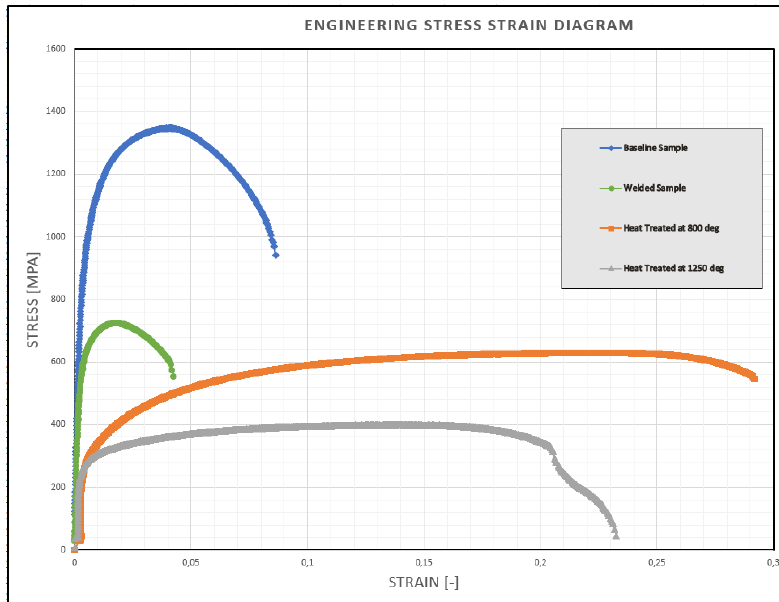
Fig 5 : Engineering Stress Strain Diagrams for (i) Baseline Sample (ii) Welded Sample (iii) Heat Treatment at 800 °C Sample (iv) Heat Treatment at 1250 °C Sample